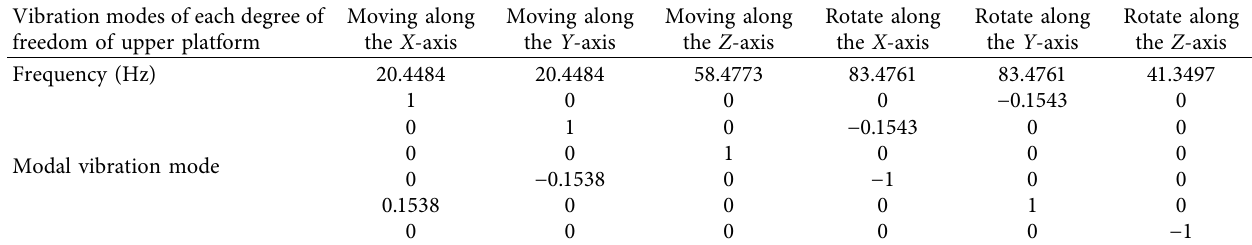
Table 2: Modal frequencies and corresponding modal shapes of the Stewart platform in Case (a). Vibration modes of each degree